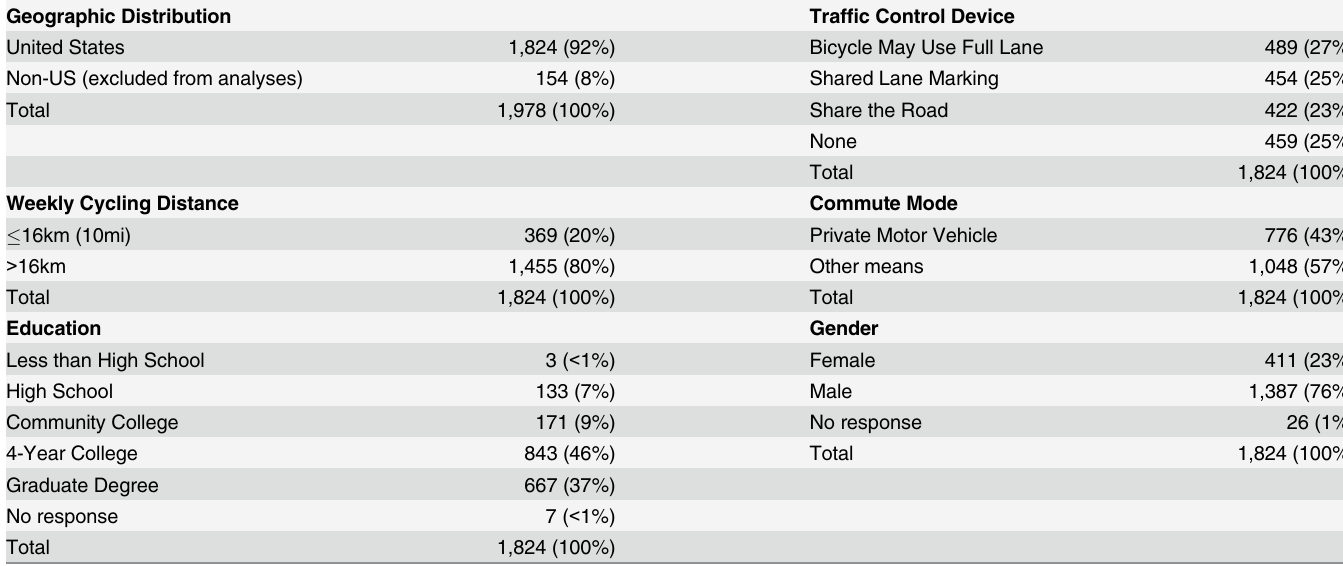
Table 1. Characteristics of our survey